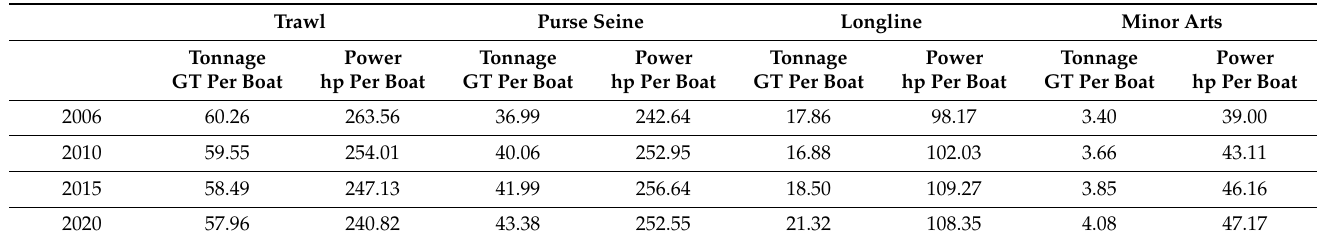
Table 1. Power (hp) and tonnage (GT) per boat by gear in the Spanish Mediterranean 5 .